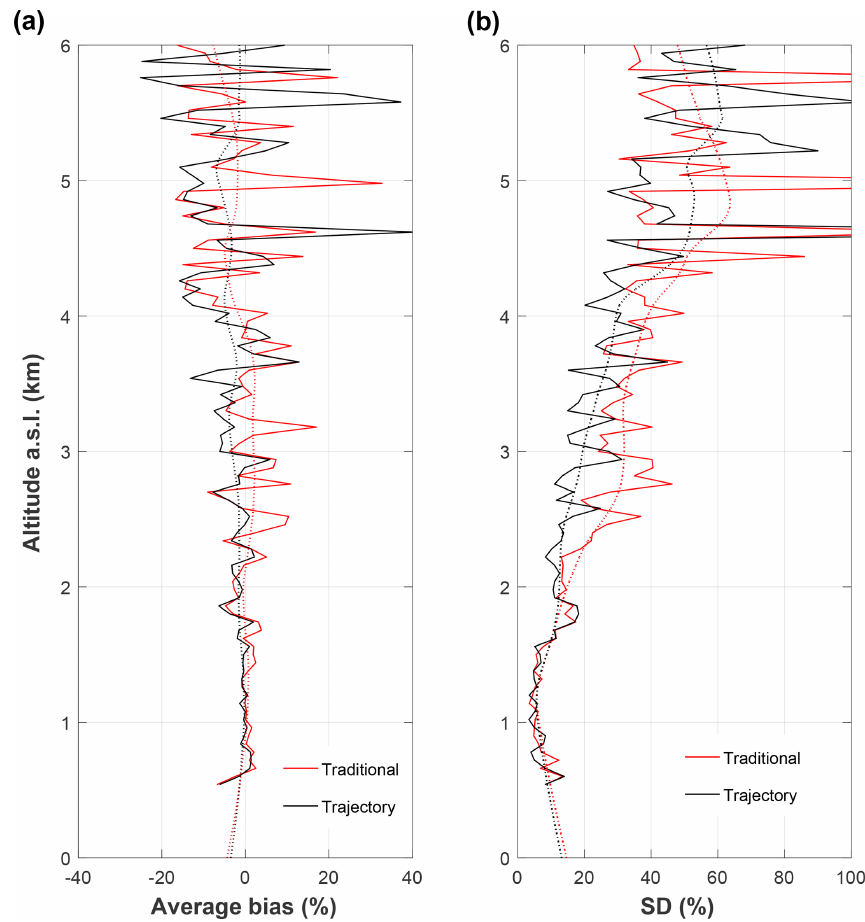
Figure 8. (a) The average bias between the radiosonde and the trajectory method calibrated profiles at 25m vertical resolution for both the trajectory (black) and traditional methods (red). Dotted lines are further smoothed results using a running average of 75m for both methods. (b) The standard deviation of all trajectory percent difference profiles at 25m resolution for both trajectory (black) and traditional (red) methods. Dashed lines are the further smoothed results by a running average of 75m for both